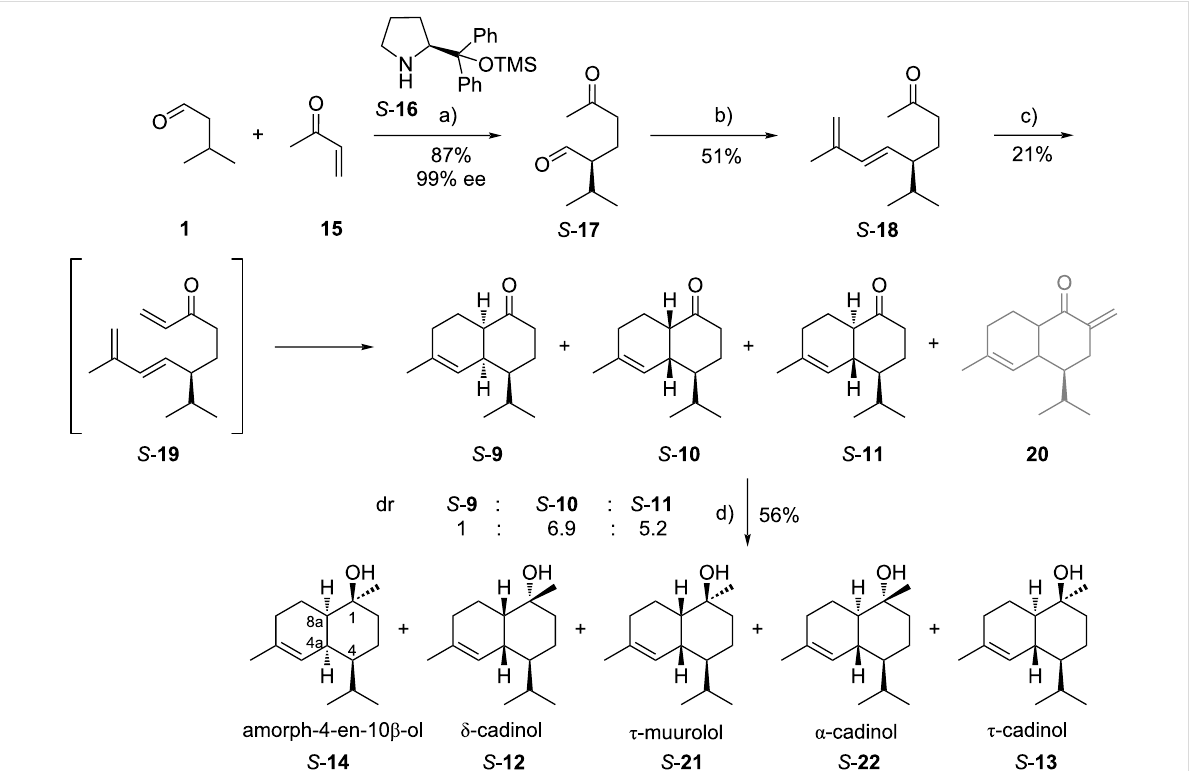
Scheme 2: Enantioselective synthesis with ( S )-Jørgensen’s organocatalyst S - 16 . Conditions: a) S - 16 (5 mol %), ethyl 3,4-dihydroxybenzoate (0.2 equiv), 4 °C, 36 h; b) i) diethyl (2-methylallyl)phosphonate (1.5 equiv), THF, − 78 °C, 10 min, ii) n -BuLi (1.5 equiv), THF, − 78 °C, 1 h, iii) S- 17